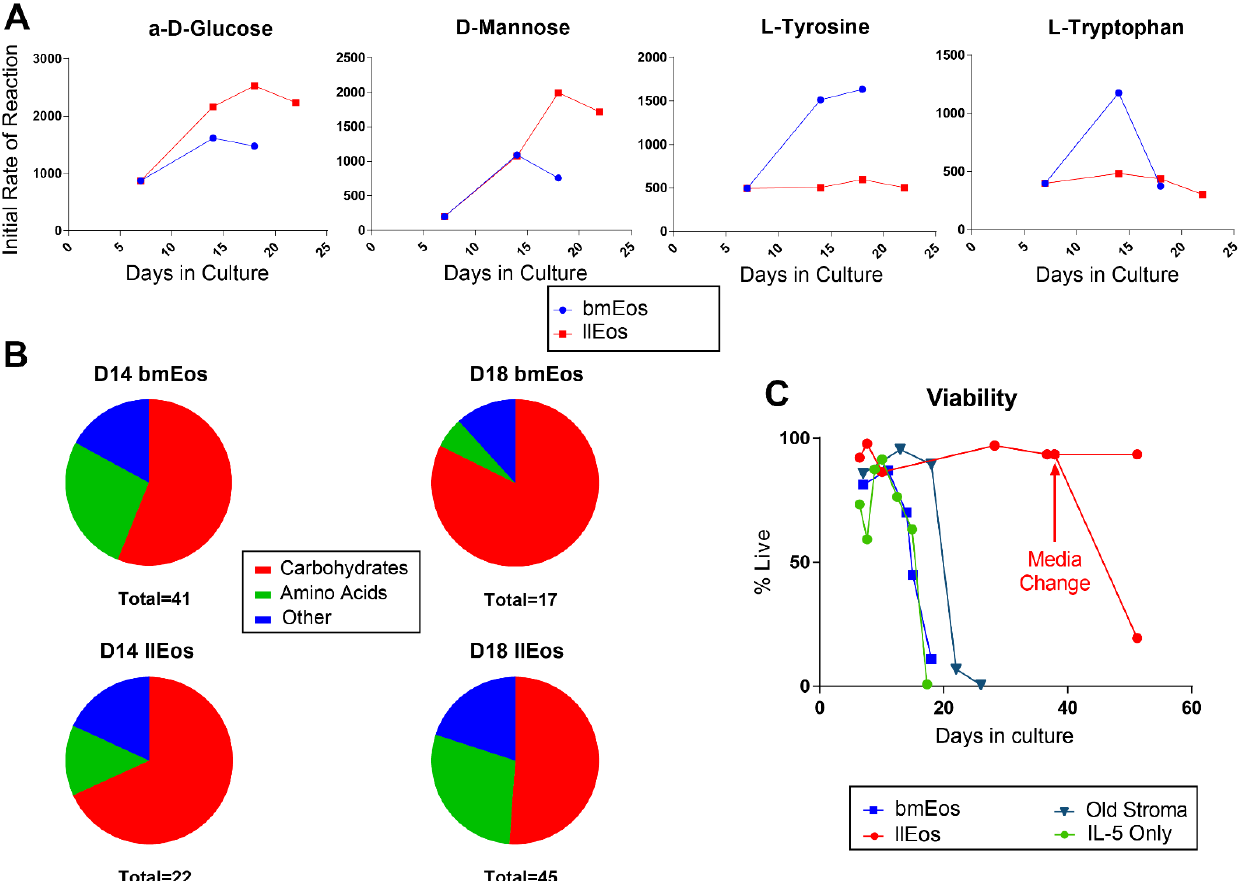
Figure 4. Conventional bmEos and long-lived llEos eosinophils have different metabolism. ( A ) llEos (red) preferentially metabolize certain sugars, such as α -D-Glucose and D-Mannose, as opposed to bmEos (blue), which have higher uptakes of select amino acids (tyrosine and tryptophan). ( B ) bmEos and llEos eosinophil cultures show differences in total number and diversity of preferred energy sources. Metabolic flexibility increases in llEos over time (more and higher diversity of energy substrates utilized), while it decreases in bmEos. ( C ) Eosinophils in llEos culture survive more than 40 days as long as the media conditions remain constant (nutrient-poor) and the flasks are not perturbed. If fresh media is added instead, the llEos culture declines in viability dramatically. N = 2 independent experiments, N = 1/Biolog assay, representative assay shown.